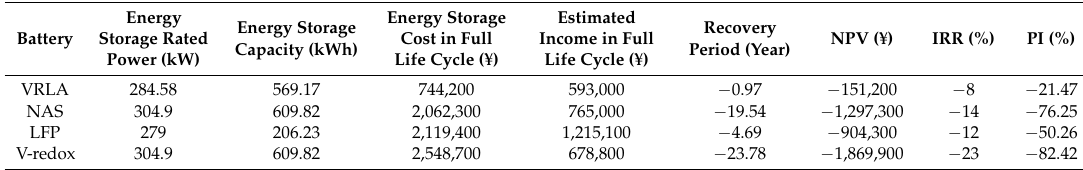
Table 5. Energy storage configuration and economic evaluation results of load peak shaving.